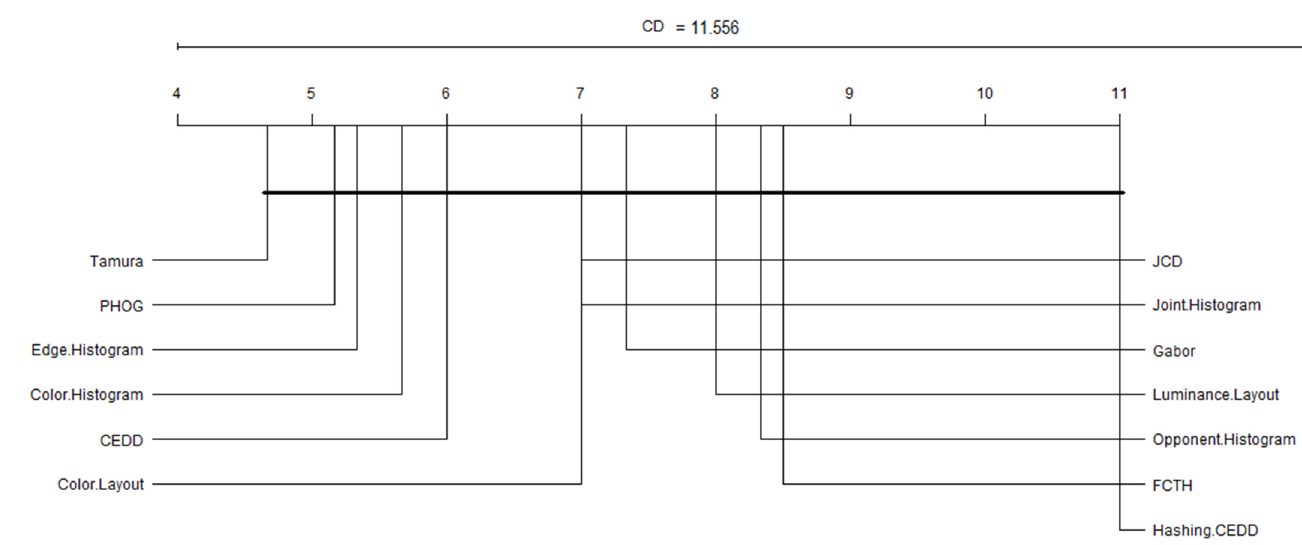
Figure 18. Critical Distance Diagram (CDD) for cropped face images.